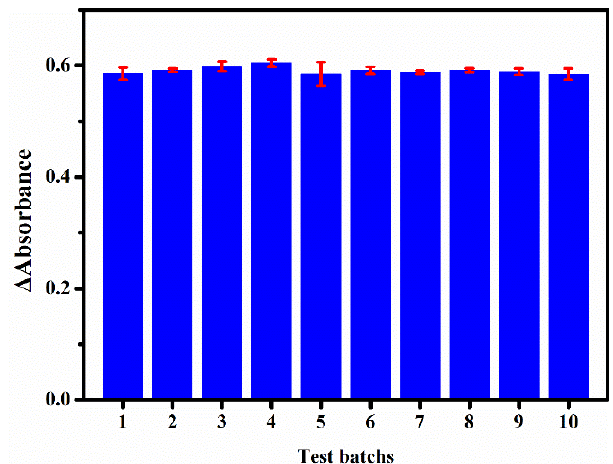
Figure 7. ΔA at 532 nm for the sensing platform for 10 batches of tests (35 μM of NaNO 2 ) at different times.